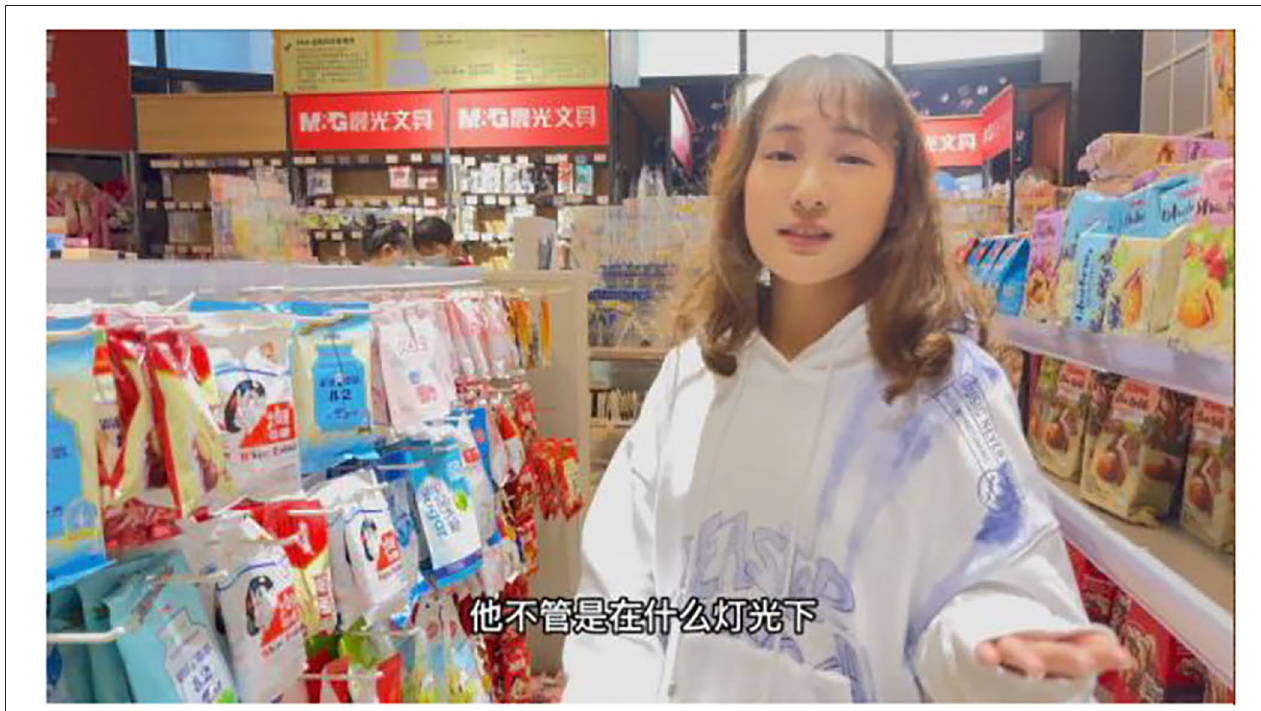
FIGURE 5 | B1 Screenshot of high co-presence.